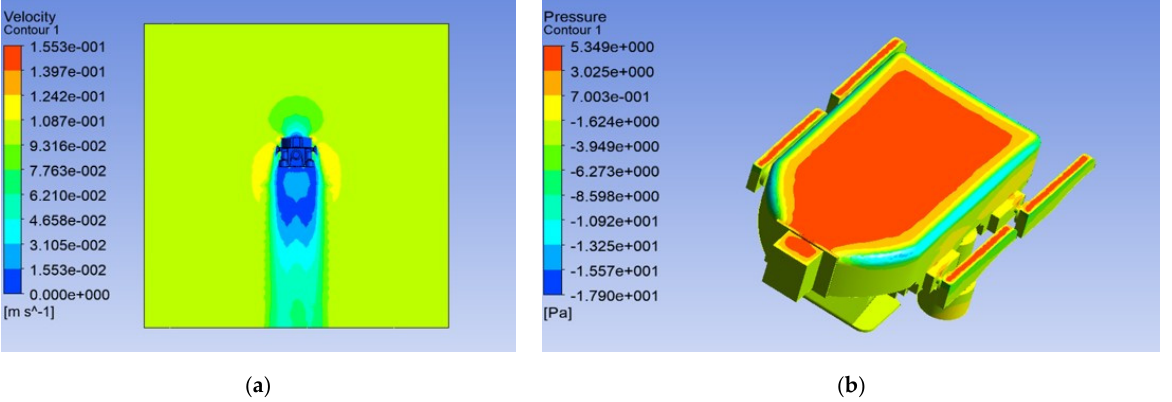
Figure 14. Simulation results in static flow field of floating motion: ( a ) result of the velocity; ( b ) result of the static pressure.